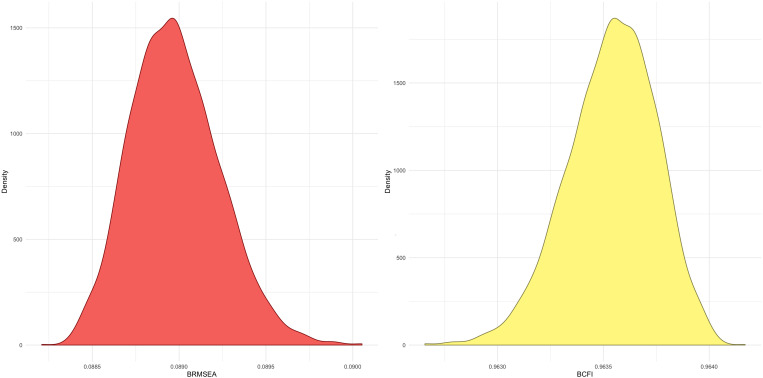
Kernel density plots of the realized posterior distributions of approximate fit indices. Note: The realized posterior distribution of the Bayesian root mean square error of approximation (BRMSEA) (left plot) and Bayesian comparative fit index (BCFI) (right plot) are displayed.